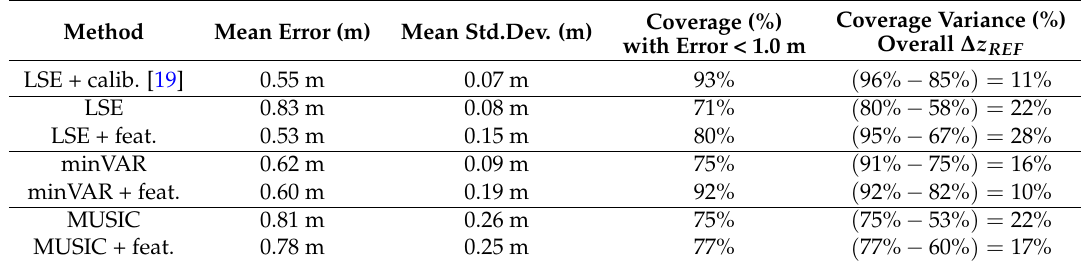
Table 2. Localization Estimation Result Comparison (Mesh Area [10 m 2 ]) @ z REF = 1.10 m.